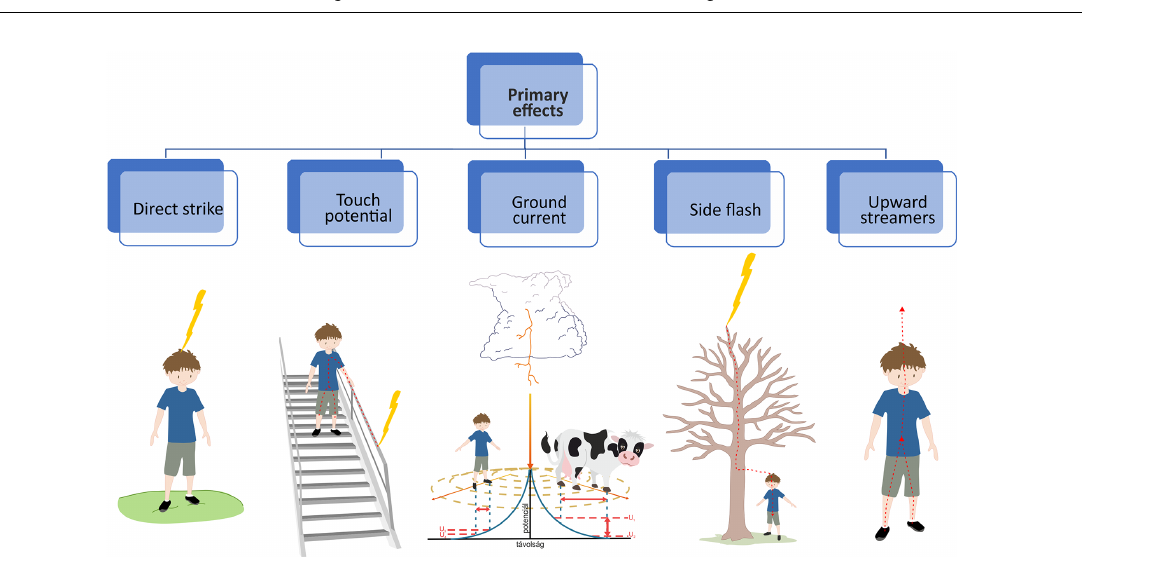
Figure 3. Primary effects of lightning strikes. (Figure created by the